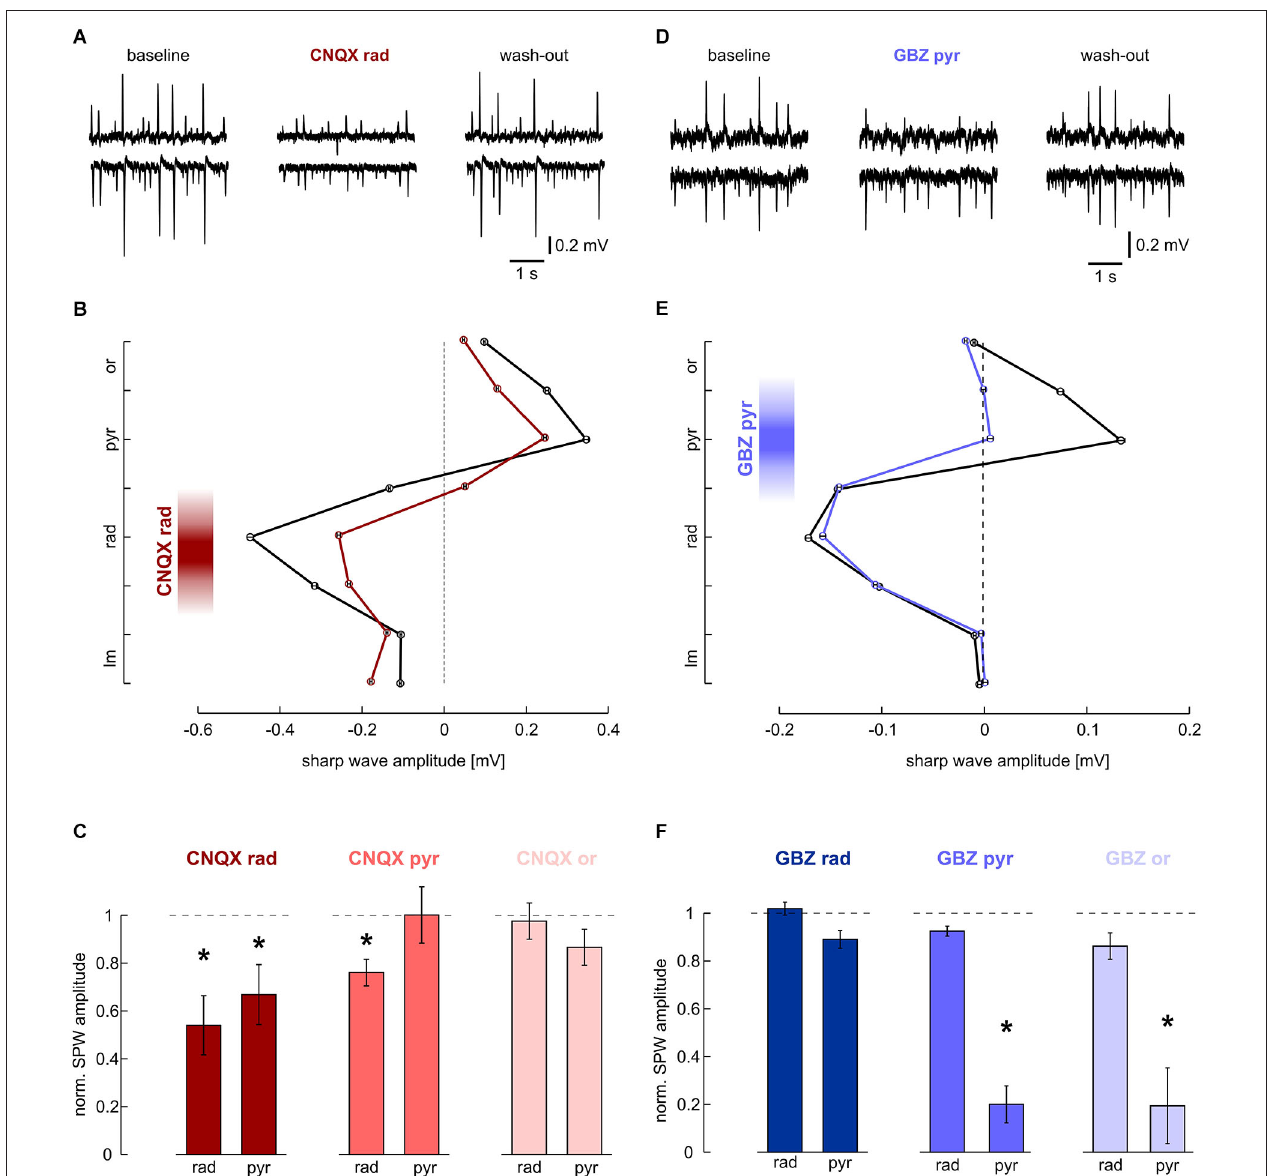
application of gabazine to s. pyramidale reversibly reduces SPW amplitude specifically in this layer. Note that in s. radiatum event amplitude and frequency are not affected. (D) LFP recordings, representative of s. pyramidale (upper trace) and s. radiatum (lower). (Left) baseline, (middle) after 40 min of local wash-in, (right) after 60 min wash-out. (E) Average SPW amplitude across CA1 before (black) and after (blue) local application of gabazine to s. pyramidale. Mean and SEM of n = 757 (baseline) and n = 494 (wash-in) sharp waves from one slice. Intervals on y-axis correspond to distance between two recording electrodes. (F) Normalized SPW amplitude in s. radiatum and s. pyramidale after local application of gabazine to (left) s. radiatum ( n = 11 slices; s. radiatum: P > 0.05, paired t test, s. pyramidale: P > 0.05, Dunn’s multiple comparisons test), (middle) s. pyramidale ( n = 6 slices; s. radiatum: P > 0.1, s. pyramidale: P < 0.01) and (right) s. oriens ( n = 8 slices; s. radiatum: P > 0.1, s. pyramidale: P <